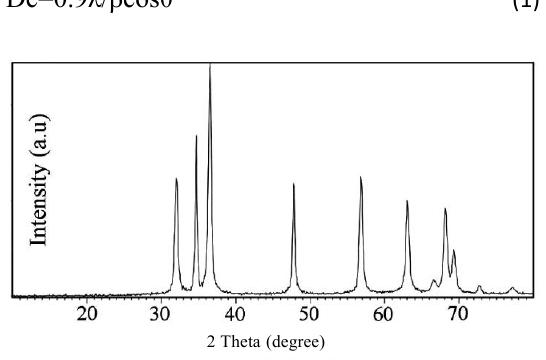
Fig. 2. XRD pattern of zinc oxide nanoparticles